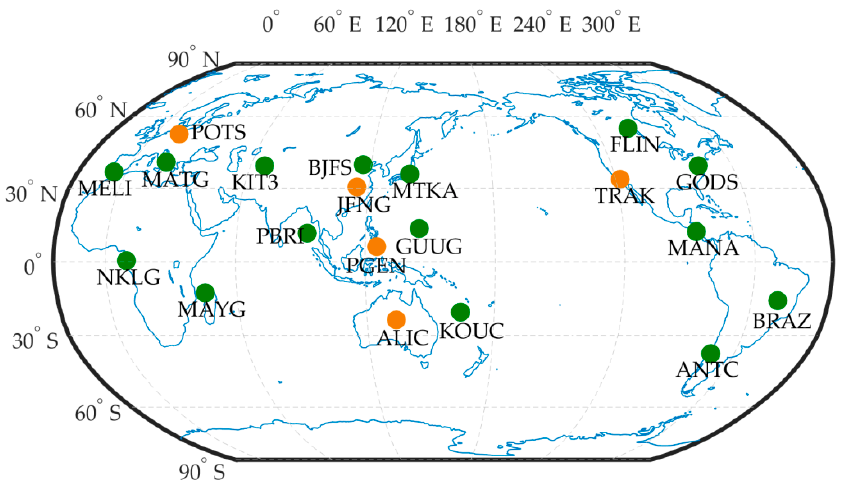
Figure 9. The distribution of 20 IGS stations for PPP validation.